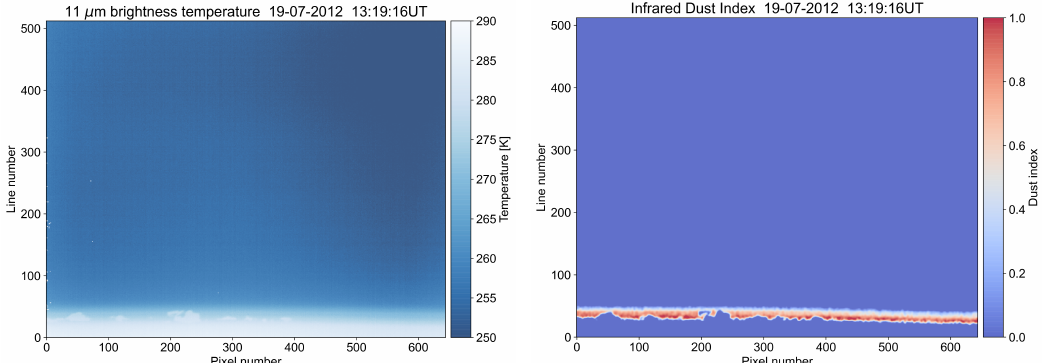
10000 m viewing clouds Figure 4. Infrared image obtained from an A340 aircraft at 10,000 m viewing clouds and windblown Figure 4. Infrared data obtained from an A340 aircraft at ∼ ∼ and windblown dust off Western Sahara on 19 July 2012. Left : Single-channel brightness dust off Western Sahara on 19 July 2012. Left: Single-channel brightness temperatures–note the low temperatures–note the low level clouds and haze layer. Right : Dust index determined by level clouds and haze layer. Right: Dust index determined by combining 11 and 12 µ m images, combining 11 and 12 µ m images, and accounting for differential gaseous absorption. and accounting for differential gaseous absorption.